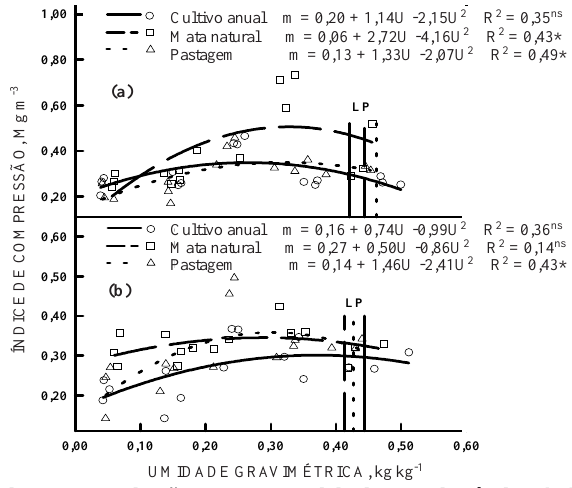
Figura 8. Relação entre a umidade gravimétrica (U) e o índice de compressão (m) para o Latossolo Roxo sob cultivo anual, mata natural e pastagem cultivada, nas profundidades de 0-0,03 (a) e 0,27-0,30 m (b), com 15 repetições (a linha vertical representa o limite de plasticidade (LP), com três repetições). *, **, ns significativos a 5 e 1% e não-significativo, respectivamente.